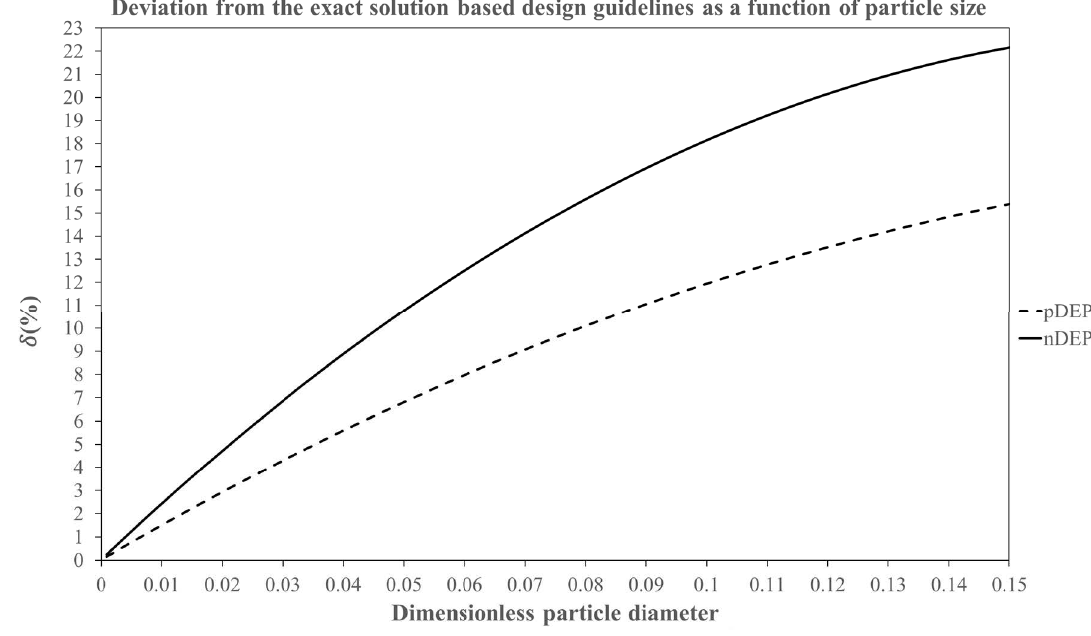
Figure 2. % Deviation of the dimensionless parameter generated from the curve fitting equations for pDEP (Equation (27)) and nDEP (Equation (28)) from its value predicted by the exact solution (Equation (21)) as a function of the dimensionless particle diameter d ∗ . Note that the curve fitting equations deviate increasingly from the exact solution for both pDEP and nDEP with increasing particle diameters, indicating the increasing influence of the wall repulsion forces on the C-iDEP particle dynamics with particle blockage.